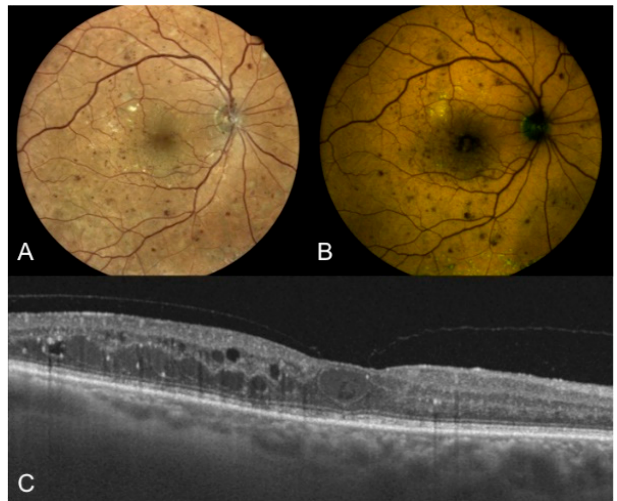
Figure 3. Right eye of a 67-year old male patient affected by type two DM with proliferative DR. ( A ) True-color fundus photography of the posterior pole showing NVD, multiple hemorrhages, extrafoveal hard exudates, cystoid macular edema, and peripheral laser treatment; ( B ) color-FAF of the same eye with detected values of foveal GEFC and REFC intensity of 31 and 40, respectively; ( C ) OCT horizontal B-scan centered on the fovea showing center involving cystoid macular edema (CRT = 356 μ m), hard exudates, and hyper-reflective intraretinal spots. DM: diabetes mellitus; DR: diabetic retinopathy; NVD: new vessels at disc; FAF: fundus autofluorescence; GEFC/REFC: green/red emission fluorescence components; OCT: optical coherence tomography; CRT: central retinal thickness.